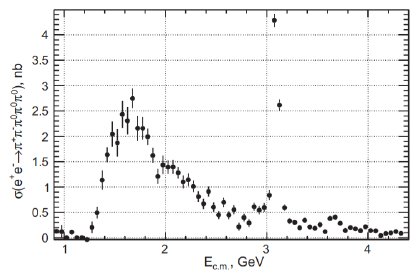
Figure 2. Number of events in bins of E c . m . from the ηπ + π − (triangles), ωπ 0 π 0 (upside- down triangles), and ρ ± π ∓ π 0 π 0 (squares) inter- mediate states. The circles show the total event numbers of signal events.